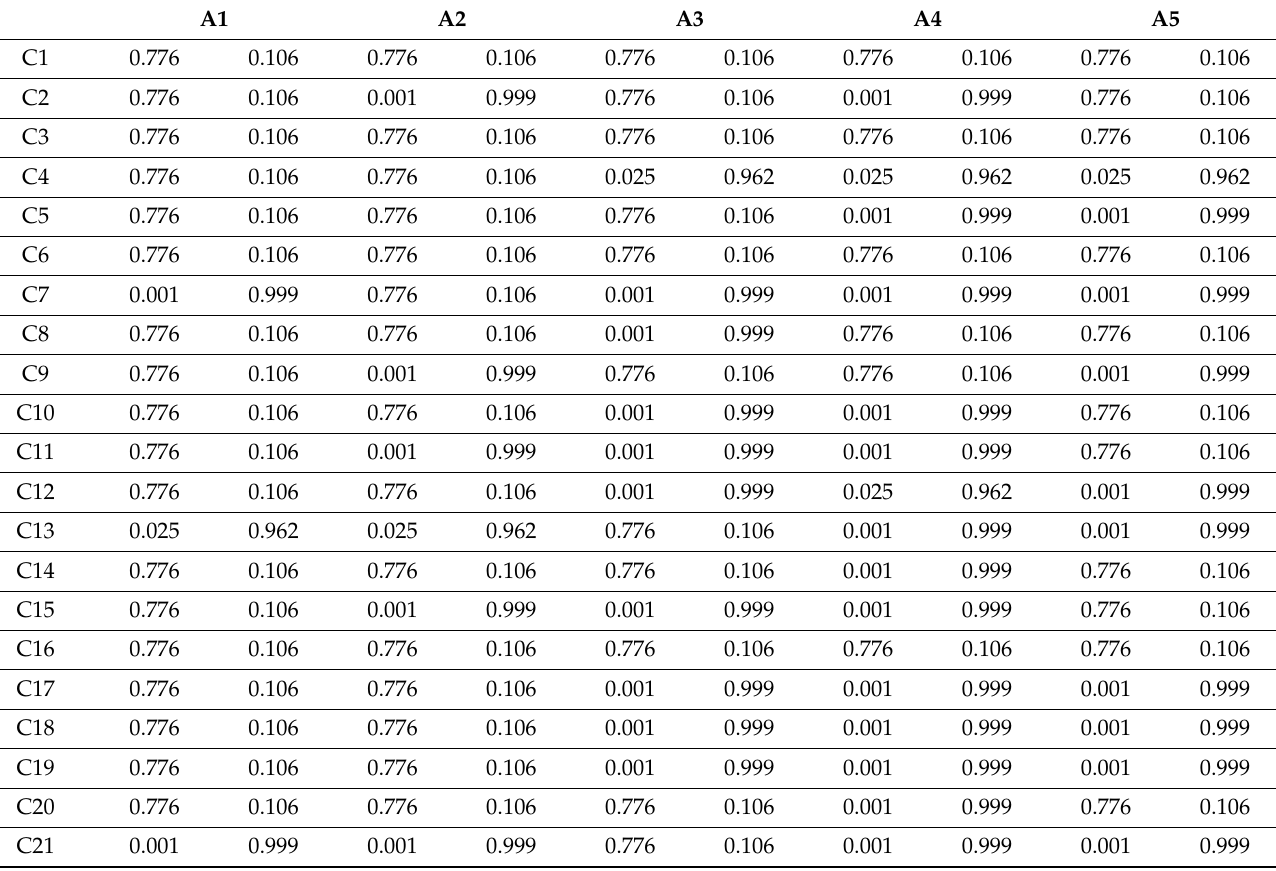
Table 4. The decision matrix T (IFNs).